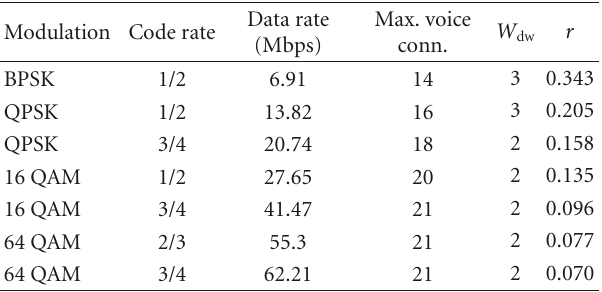
Table 1: The maximum numbers of supported voice connections under di ff erent 802.16 PHY-layer modes.